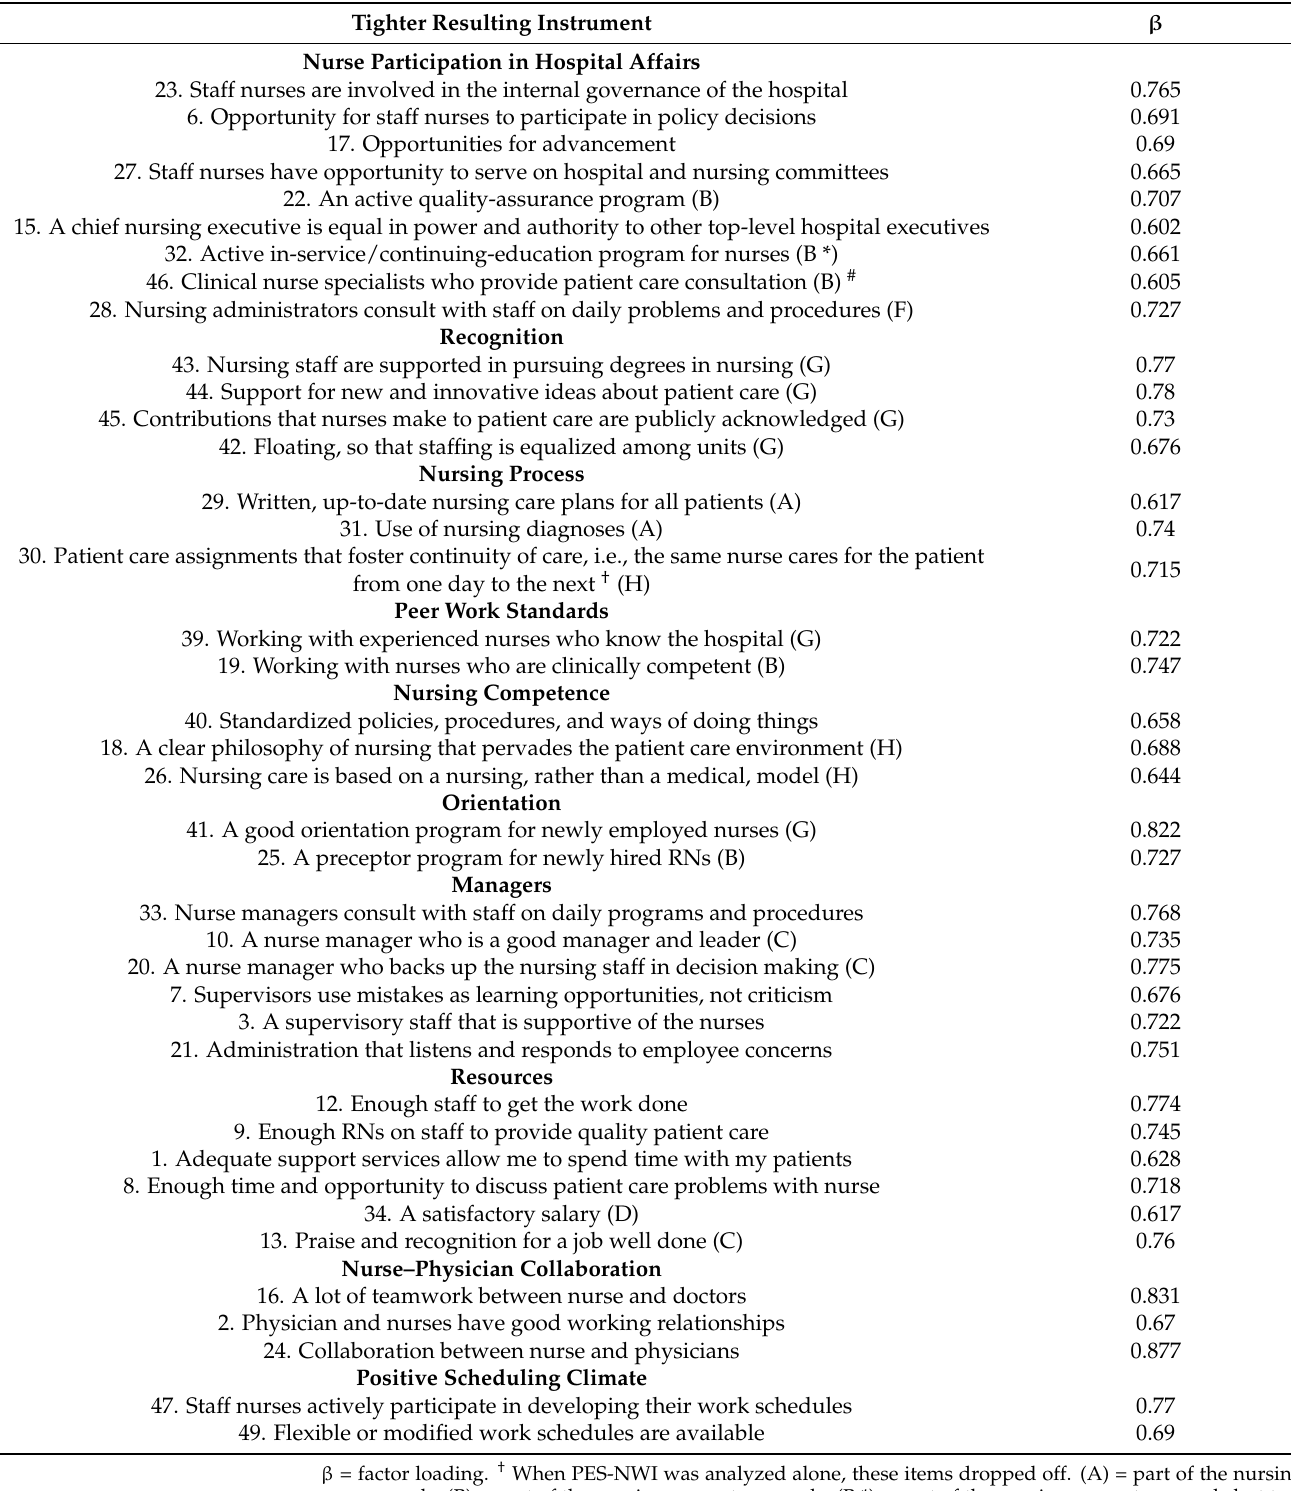
Table 2. The final resulting factor structure including the loadings (>0.6) for each factor. Tighter Resulting